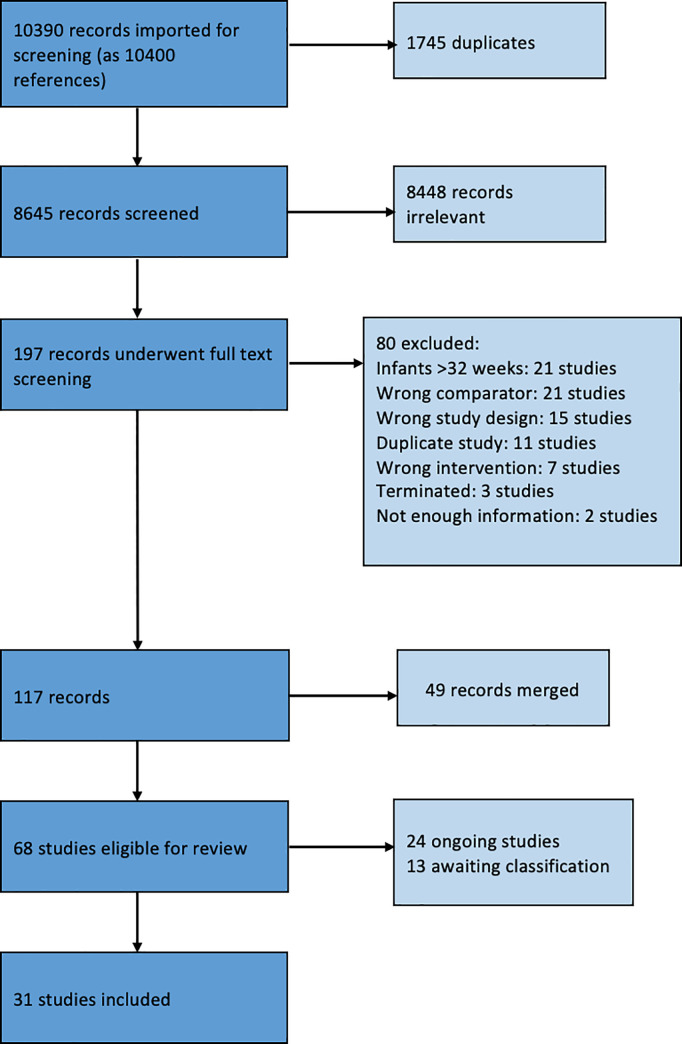
PRISMA flow diagram.